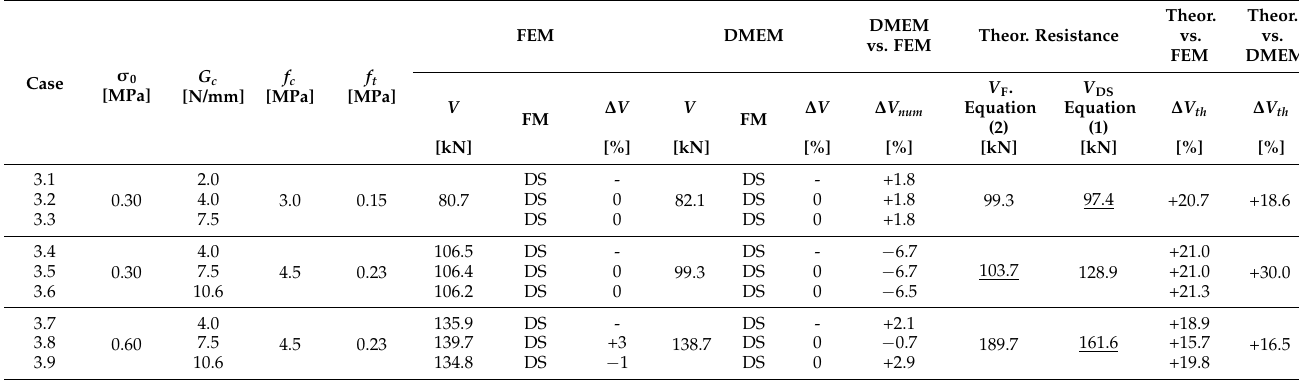
Table 9. Shear resistances of Group